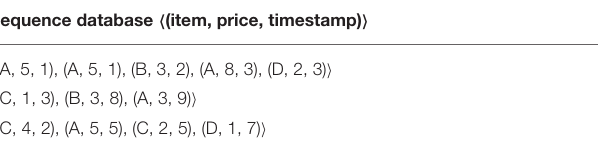
TABLE 1 | Example sequence database with three sequences and two attributes, price and timestamp. Sequence database h (item, price, timestamp)